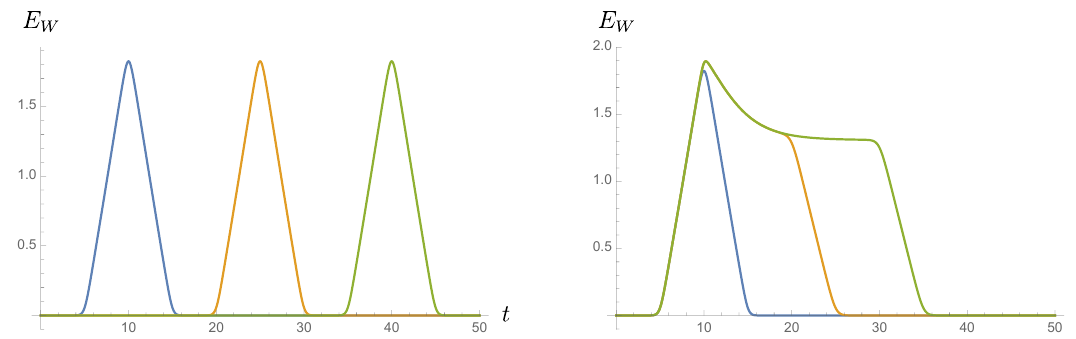
Figure 6 . Global inhomogeneous quench: (cid:12) = 2 ; c = 1 ; (cid:21) = 3 (left) l 1 = l 2 = 10 ; d = f 10 ; 25 ; 40 g (right) l 1 = 10 ; l 2 = f 10 ; 30 ; 50 g ; d = 10. The late-time value is, again, exponentially small, given by the thermal value